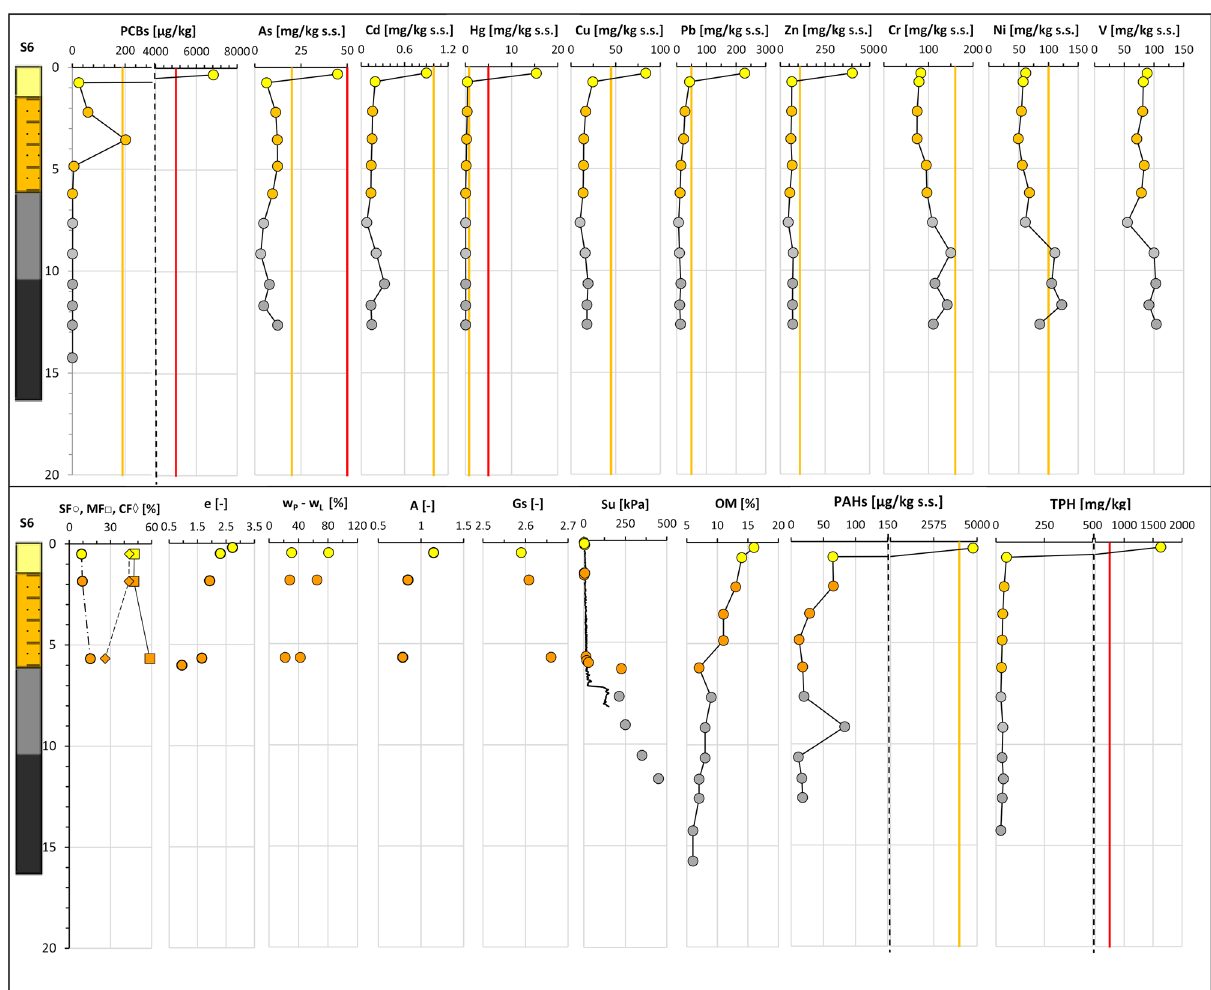
Figure 18. Vertical profiles of chemical and geotechnical properties along the S6 borehole in the I Bay of the Mar Piccolo